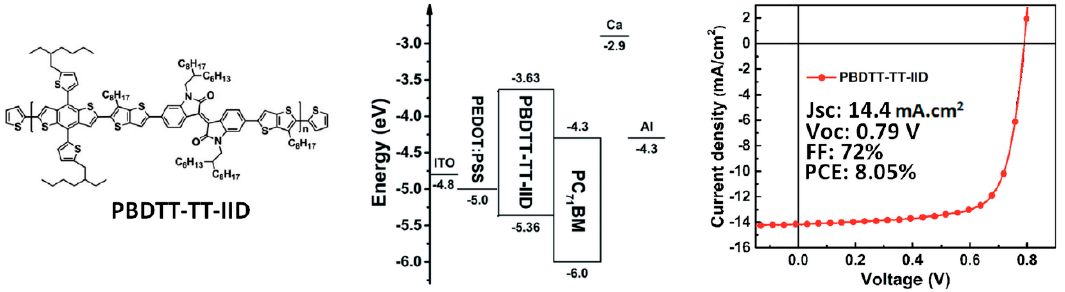
Figure 8. Molecular structure of PBDTT-TT-IID, energy diagram and photovoltaic properties of PBDTT-TT-IID-based OSCs. Reprinted with permission from Reference [49]. Copyright 2016 Royal Society of Chemistry.